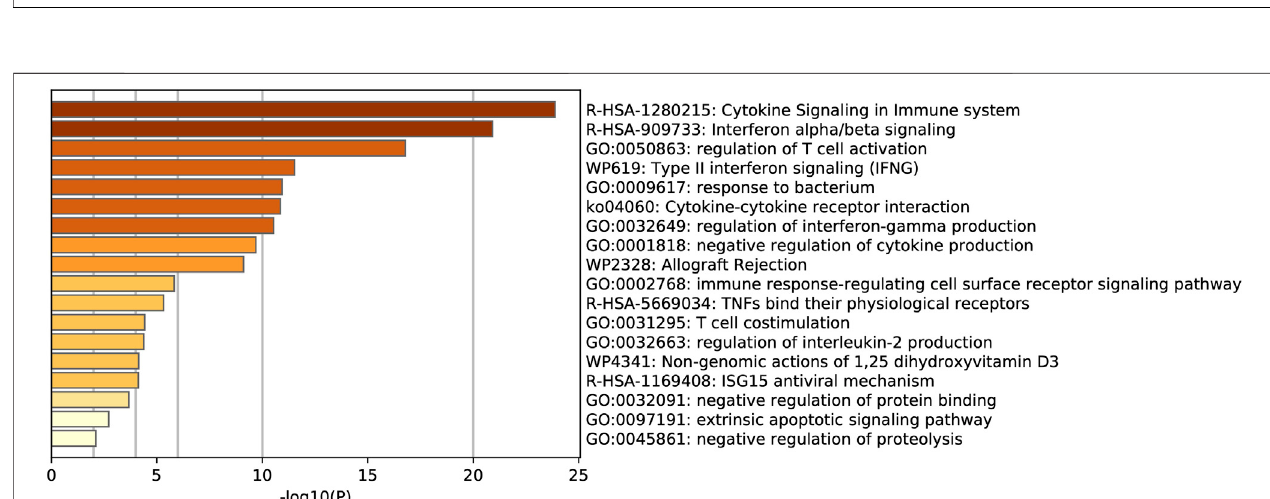
FIGURE4| GenetermenrichmentanalysisoftheDEGsforCOVID-19inGSE151764revealsthatmostgenesareinvolvedinthecytokinesignalingoftheimmunesystem.